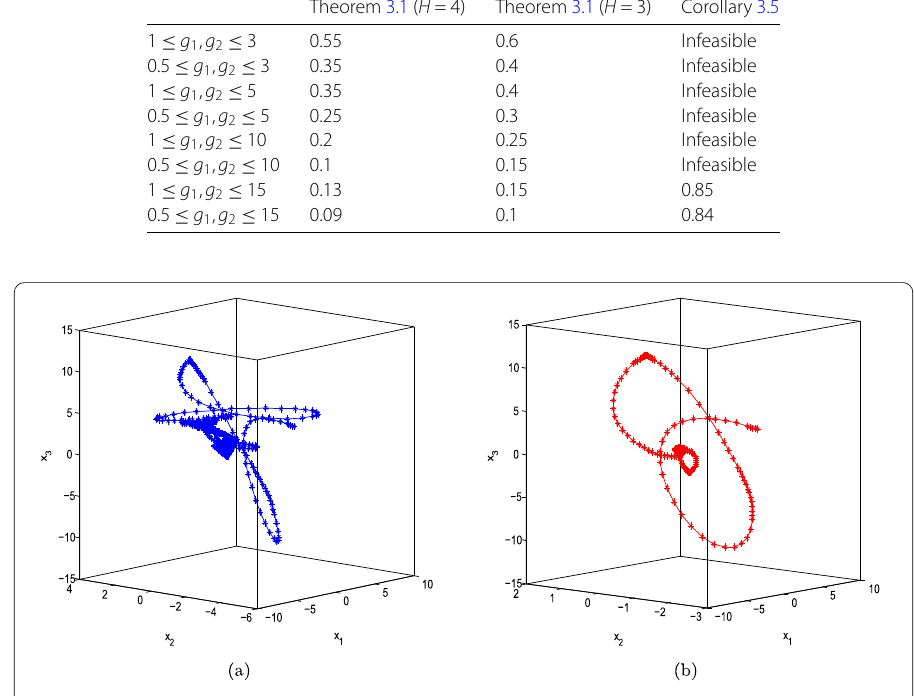
Figure 2 State response of the closed-loop system: ( a ) under periodically intermittent nonsmooth controller by using Theorem 3.1, ( b ) under periodically intermittent smooth controller by using Theorem 3.7 along with the conditions of Theorem 3.1,